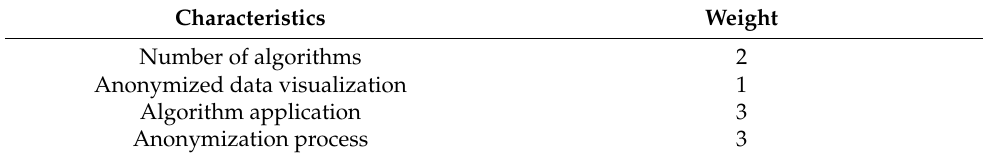
Table 1. Functionality Category—Characteristics and Weights.